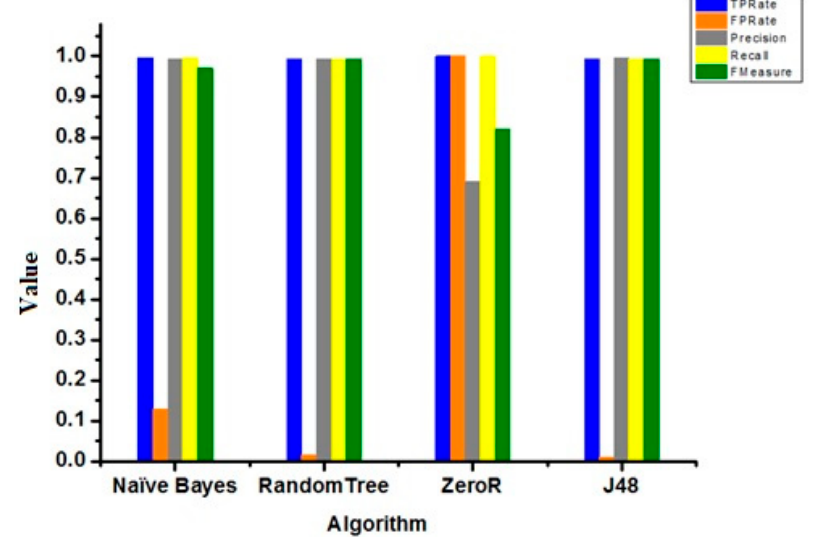
Figure 14. Graphical representation of false positive (FP), true positive (TP), precision, recall, and F-measure of different algorithms.